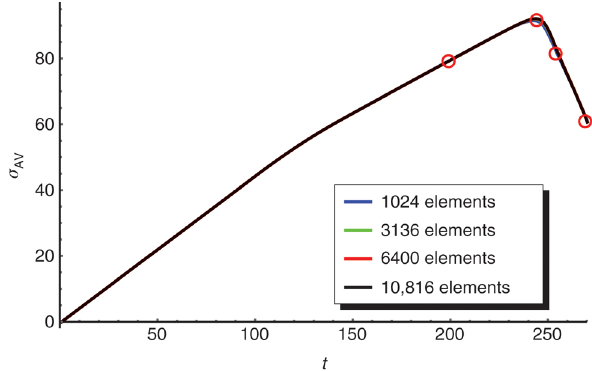
Figure 3: Tension: global stress response for 1024, 3136, 6400 and 10,816 elements (blue, green, red and black), highlighted in red at steps 200, 245, 255 and 270 (from left to